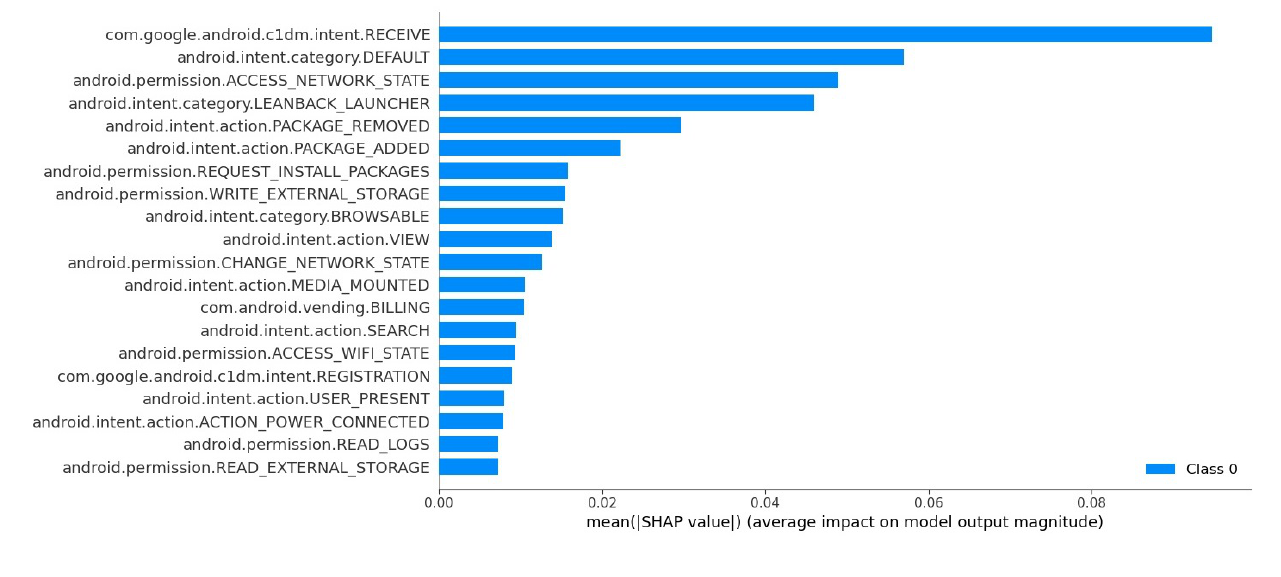
Figure 13. Features importance for the DNN model.